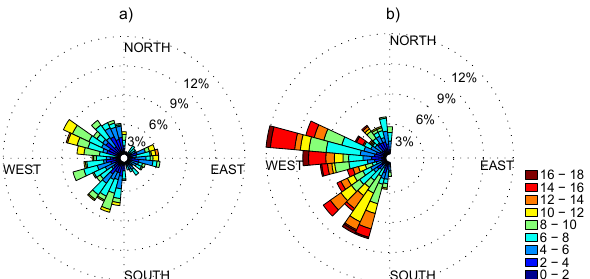
Fig. 10. Wind roses for (a) September 2002 and (b) September 2004. The length of each bar indicates the frequency of a particular wind direction and the colour of the bar indicates the wind